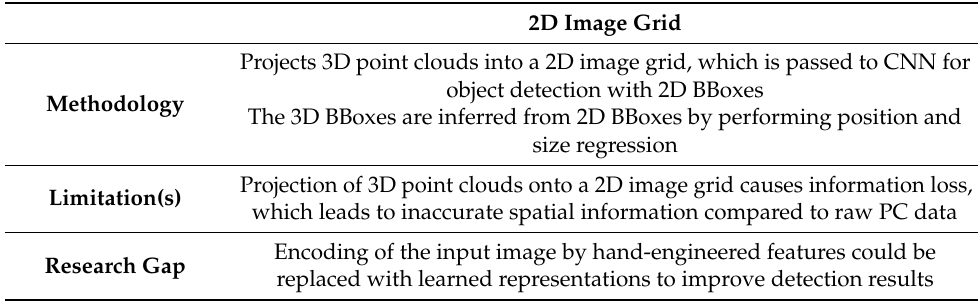
Table 10. Methodology and Limitation(s): 2D Image Grid-based 3DOR